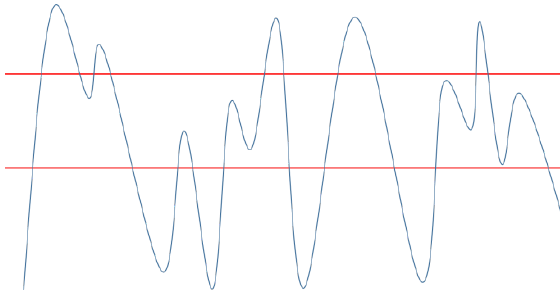
Figure 6. Using two thresholds to accurately count steps.